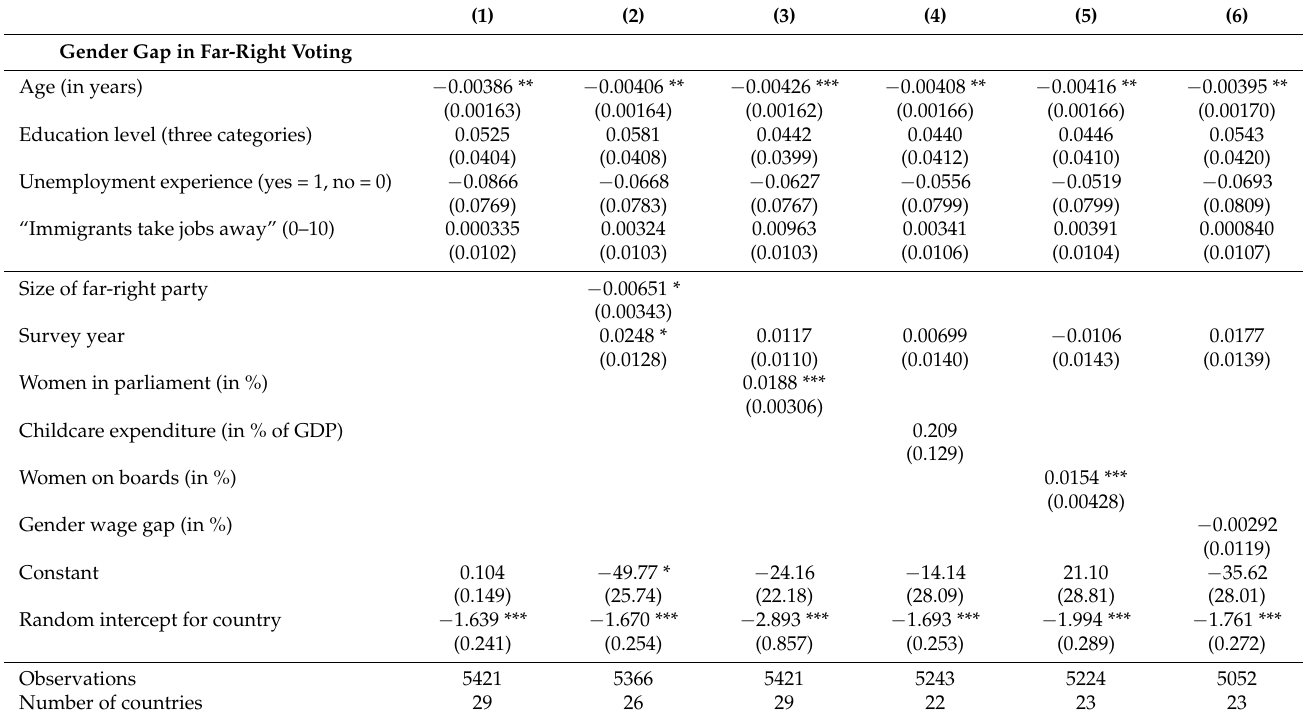
Table A6. Mixed-effects logit regression to explain the gender gap in far-right voting.